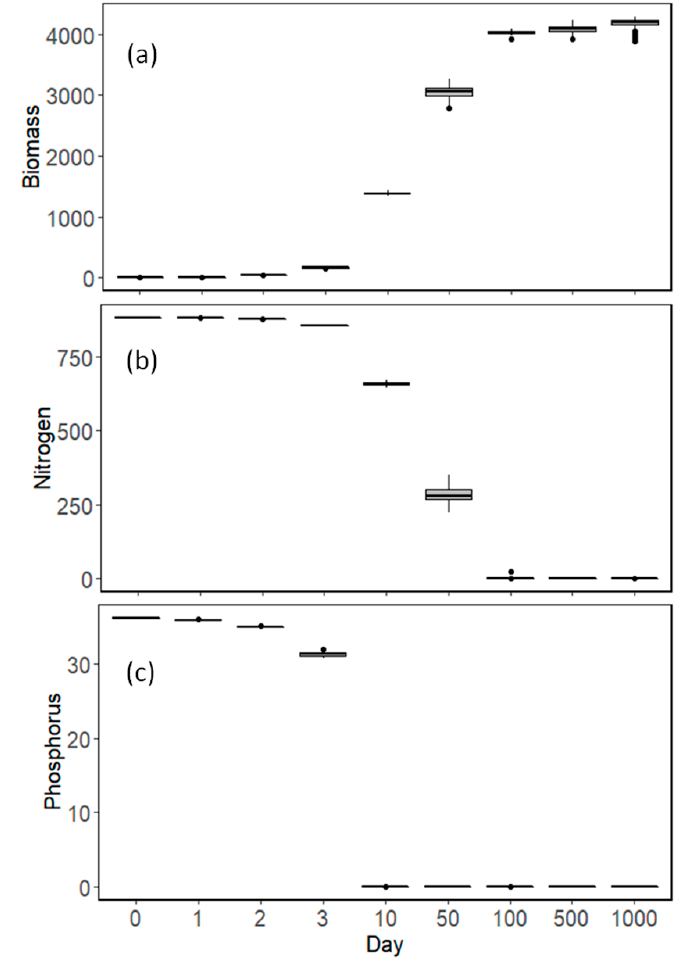
Figure 5. ( a ) Total biomass and nutrient concentrations; ( b ) nitrogen and ( c ) phosphorus during time succession in model simulations.